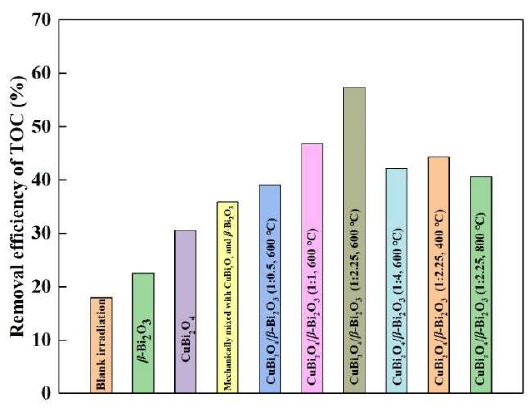
Figure 6. Total Organic Carbon (TOC) removal efficiency of the DS photodegradation solutions in different photocatalytic systems.